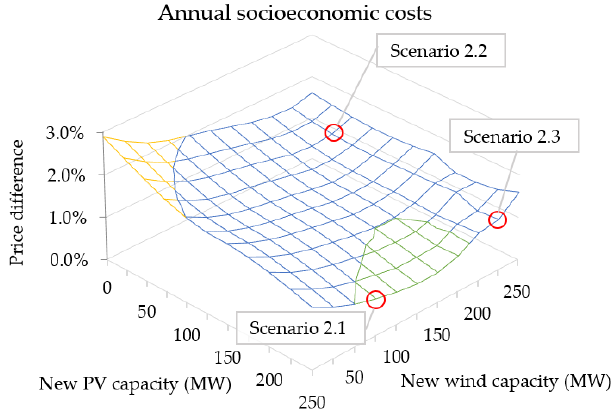
Figure 5. Sensitivity study for a smart energy system, including proposed scenarios—resulting annual socioeconomic costs, relative difference to Scenario 1.1.